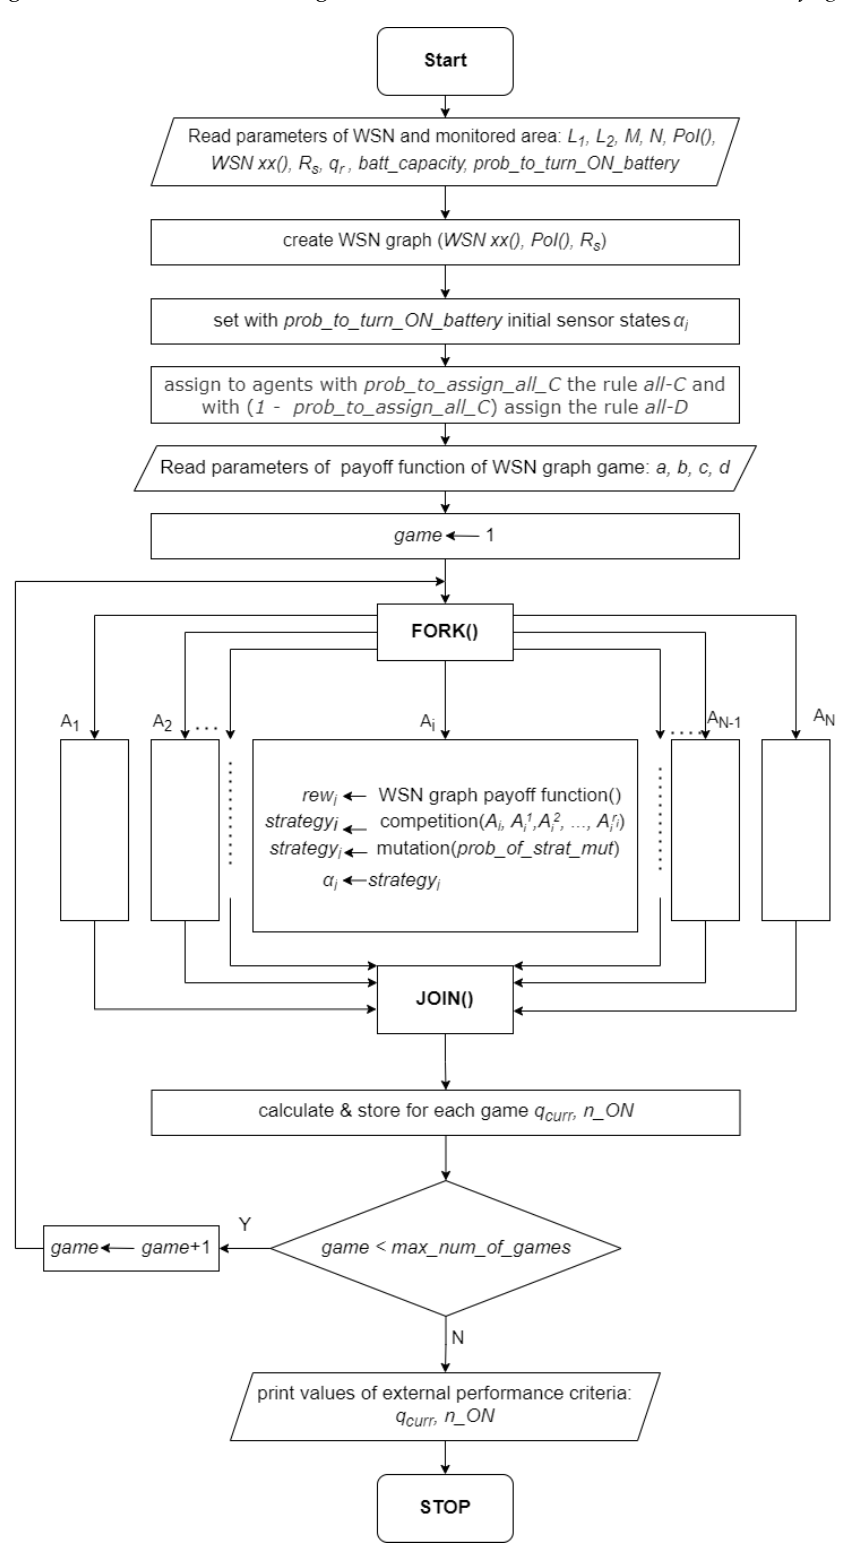
Figure 4. Flowchart of Competitive Co-evolutionary CA-based System for self-optimization of